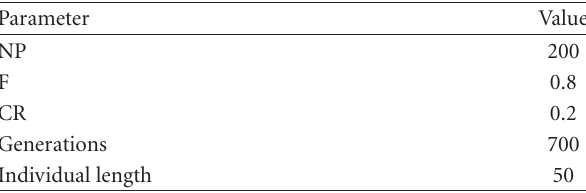
Table 2: Setting of